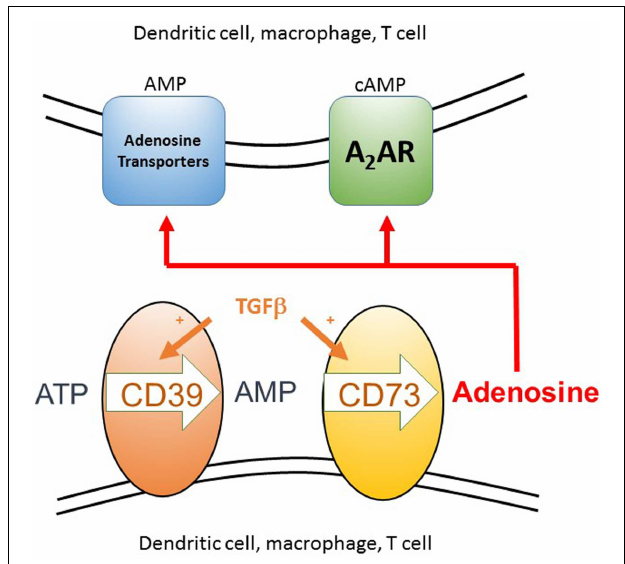
FIGURE 3 |The generation of extracellular adenosine as a component of an anti-inflammatory microenvironment . Extracellular ATP arises as a result of cell death, either from the host or pathogen, as can itself be inflammatory.The two ectoenzymes CD39 and CD73 are normally co-expressed constitutively onTreg cells, but can be induced on the surface of many different cell types, including conventionalT cells, dendritic cells, and macrophages, in the presence of a source ofTGF β .These enzymes sequentially convert extracellular ATP to AMP and then adenosine. Adenosine can then act either by binding to the A2A receptor onT cells and DC, which signals via cAMP or it can be taken up via adenosine transporters where it is rapidly converted to intracellular AMP by adenosine kinase.These two signaling pathways act to inhibit inflammation andT cell proliferation. AMP activated kinase mediated inhibition of the mTOR pathway can then occur downstream of either signaling pathway.